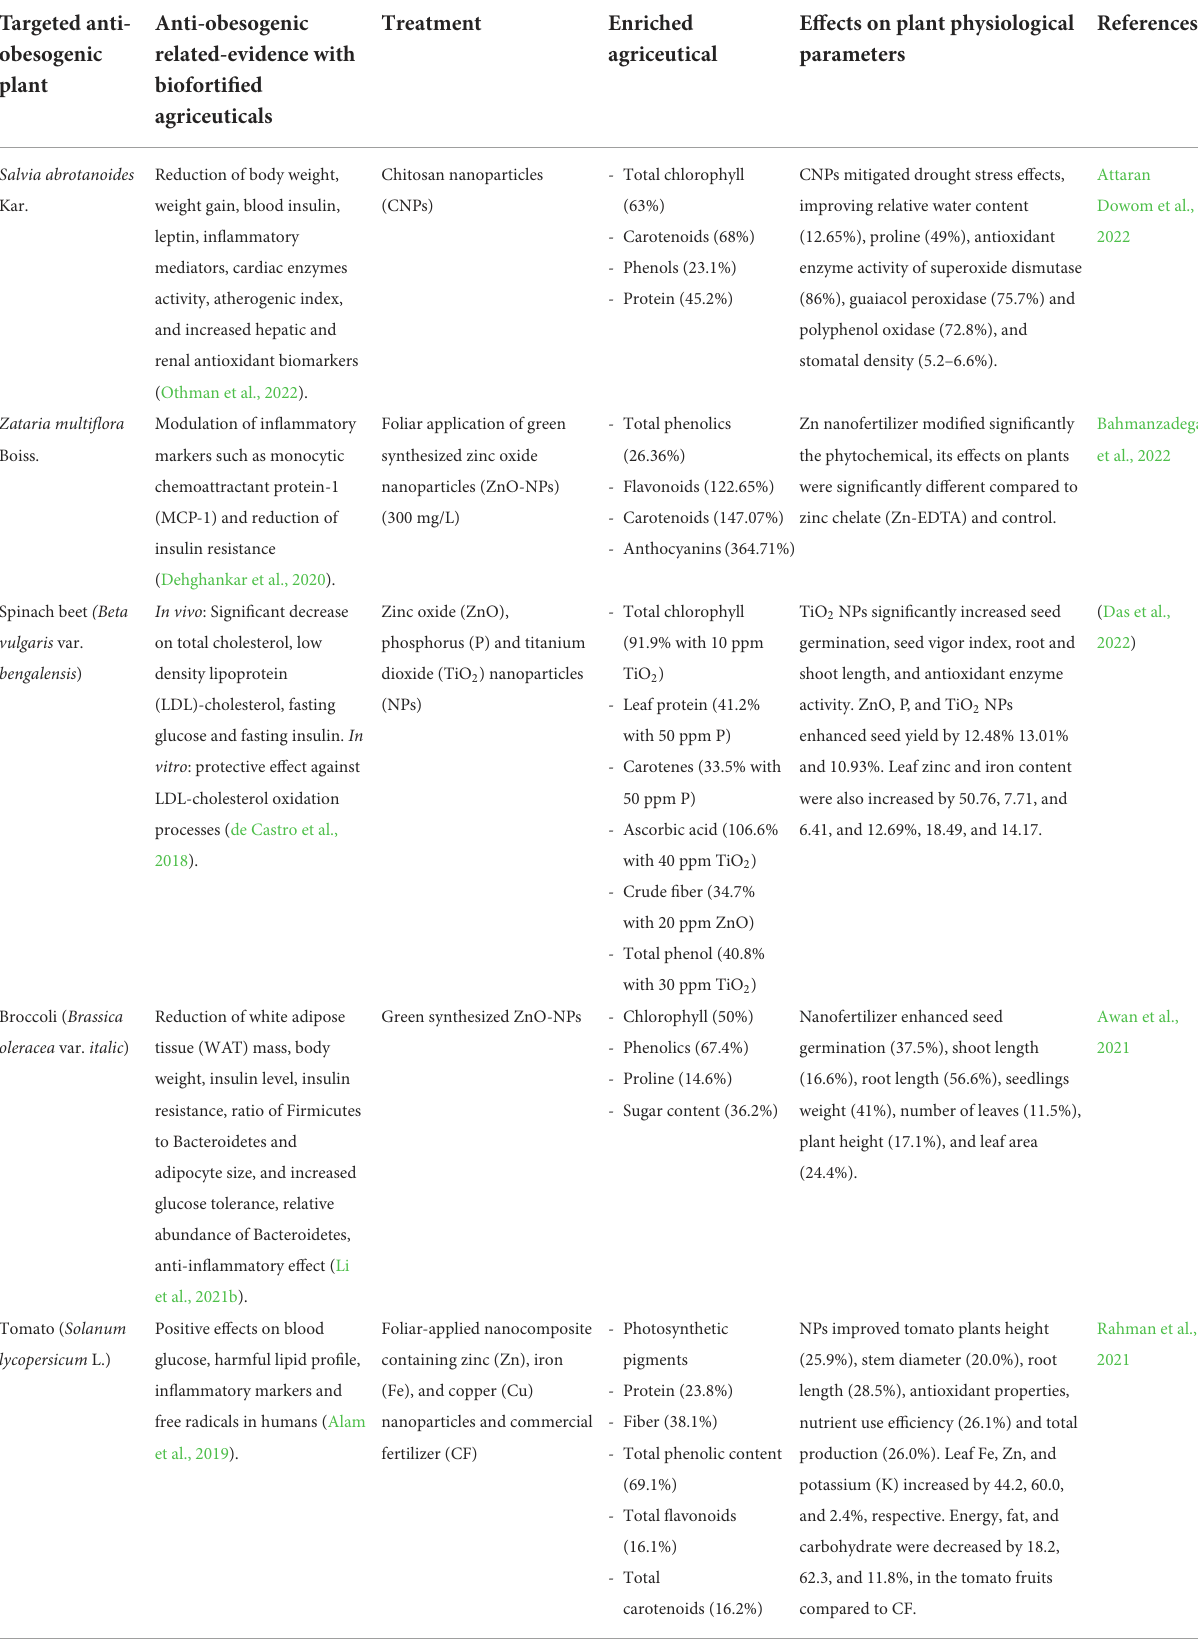
TABLE 2 Studies of biofortification with anti-obesogenic agriceuticals using nanoparticles during plant cultivation. Targeted